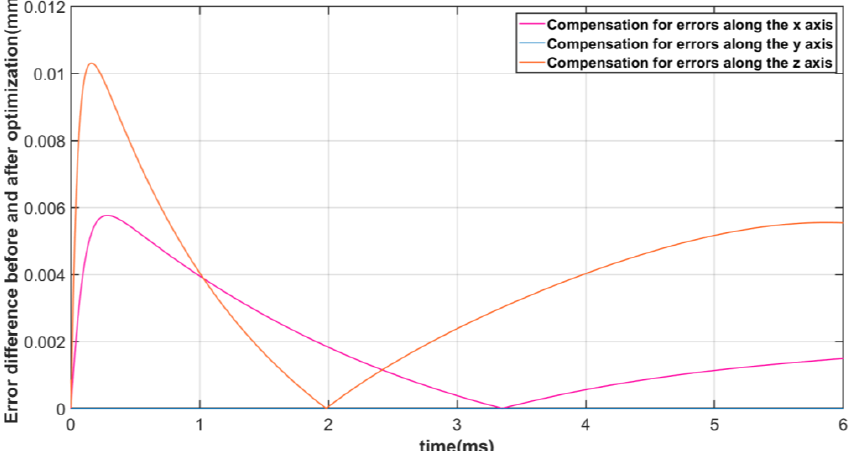
Figure 18. Error optimization effect of actual and expected motion trajectory of mobile platform. Table 6. Paired samples t -test.